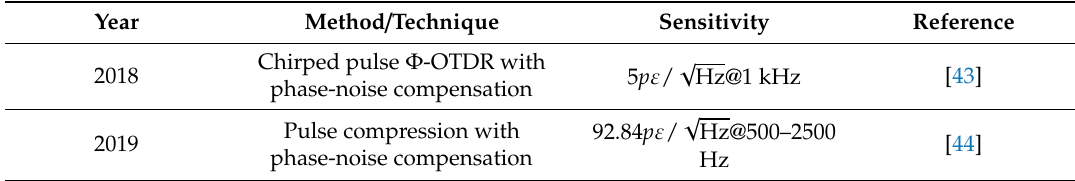
Table 4. Typical response bandwidth with di ff erent